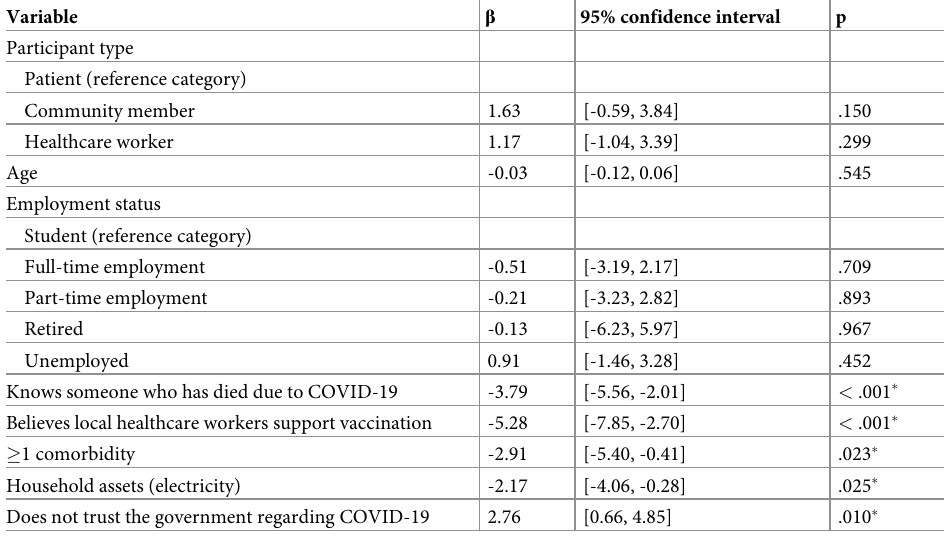
Table 4. Multivariable linear regression statistics evaluating variables associated with vaccine hesitancy in